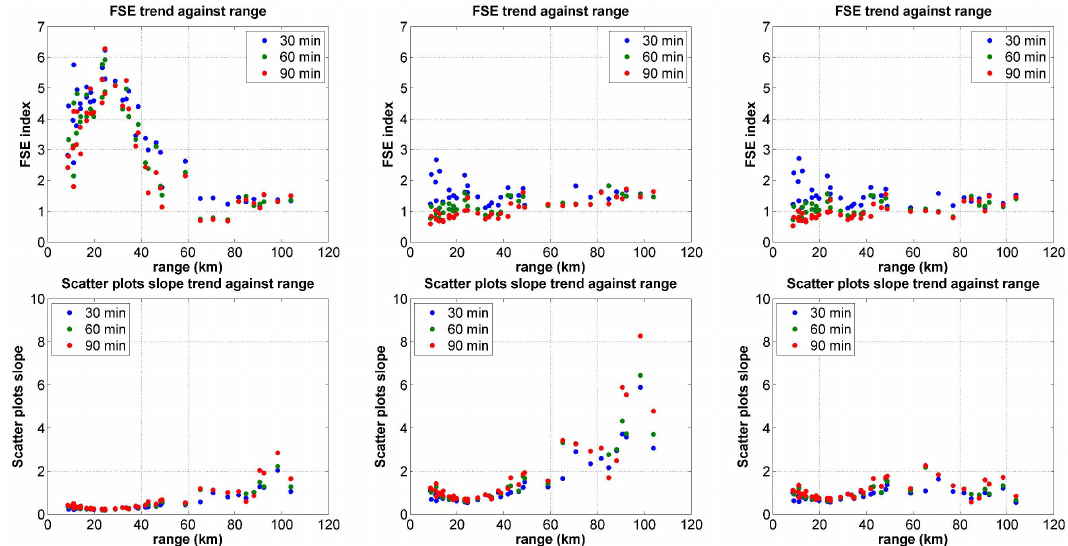
Fig. 18. FSE trend and slope of the scatter plots’ regression lines’ trend with range (plots on the top and on the bottom respectively) of rainfall time series pairs obtained during 2009 by Polar 55C and by each rain gauge for the initial data sets, after calibration, and after the adjustment procedure (left panels, middle panels and right panels, respectively). Dots in blue, in green and in red correspond to an accumulation time of 30, 60 and 90 min, respectively.